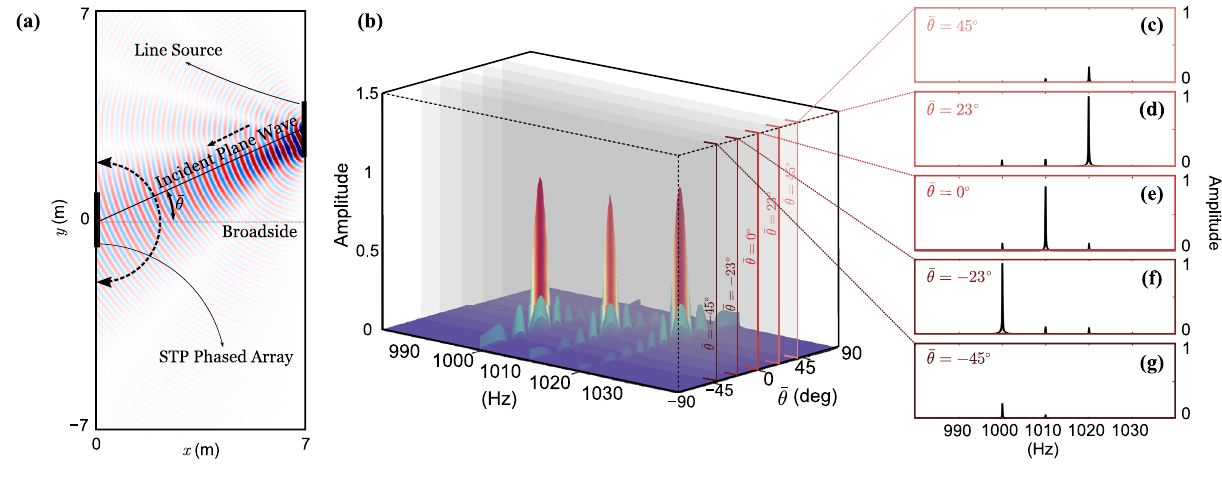
1.5 . A wave is incident upon the array from an Figure 8. ( a ) The STP phased array in RX mode with δ = ω . ( b ) FFT amplitude of the collected output signal for waves arbitrary angle ¯ θ with a dominant frequency of ¯ 90 90 1 2 π 1010 Hz incident from ¯ θ ranging from ◦ to ◦ with ◦ increments. Parameters used are as follows: ¯ ω/ − = 0 23 45 10 Hz. ( c – g ) Slices of ( b ) at different incident directions: θ and ω m / 2 π 1 ◦ , ◦ , ¯ θ = ¯ θ s = ◦ , ¯ θ = ¯ θ s , ¯ = = = + 23 45 θ s , θ 1 ◦ , and ¯ θ = − ◦ , respectively. We note that as the incident angles match either of the three ¯ = ¯ = − − listening directions of the array, a drastically higher voltage output can be detected which can be employed to determine the direction of arrival (DOA).